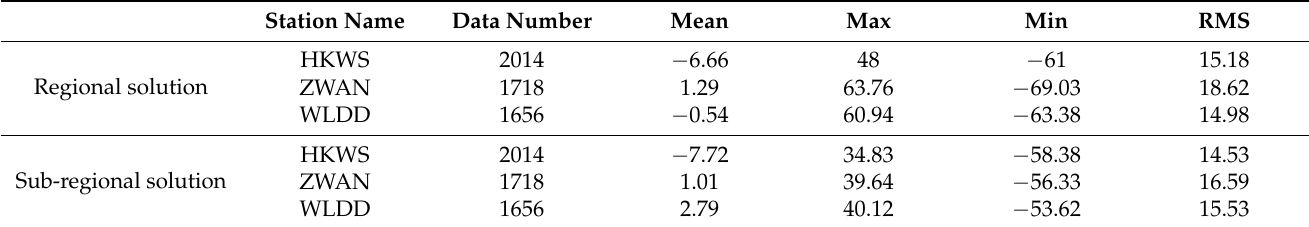
Table 3. Comparisons of ZWD between the radiosonde and PGSs (PGSs—radiosonde). (Unit: mm) The distance was from the radiosonde to the